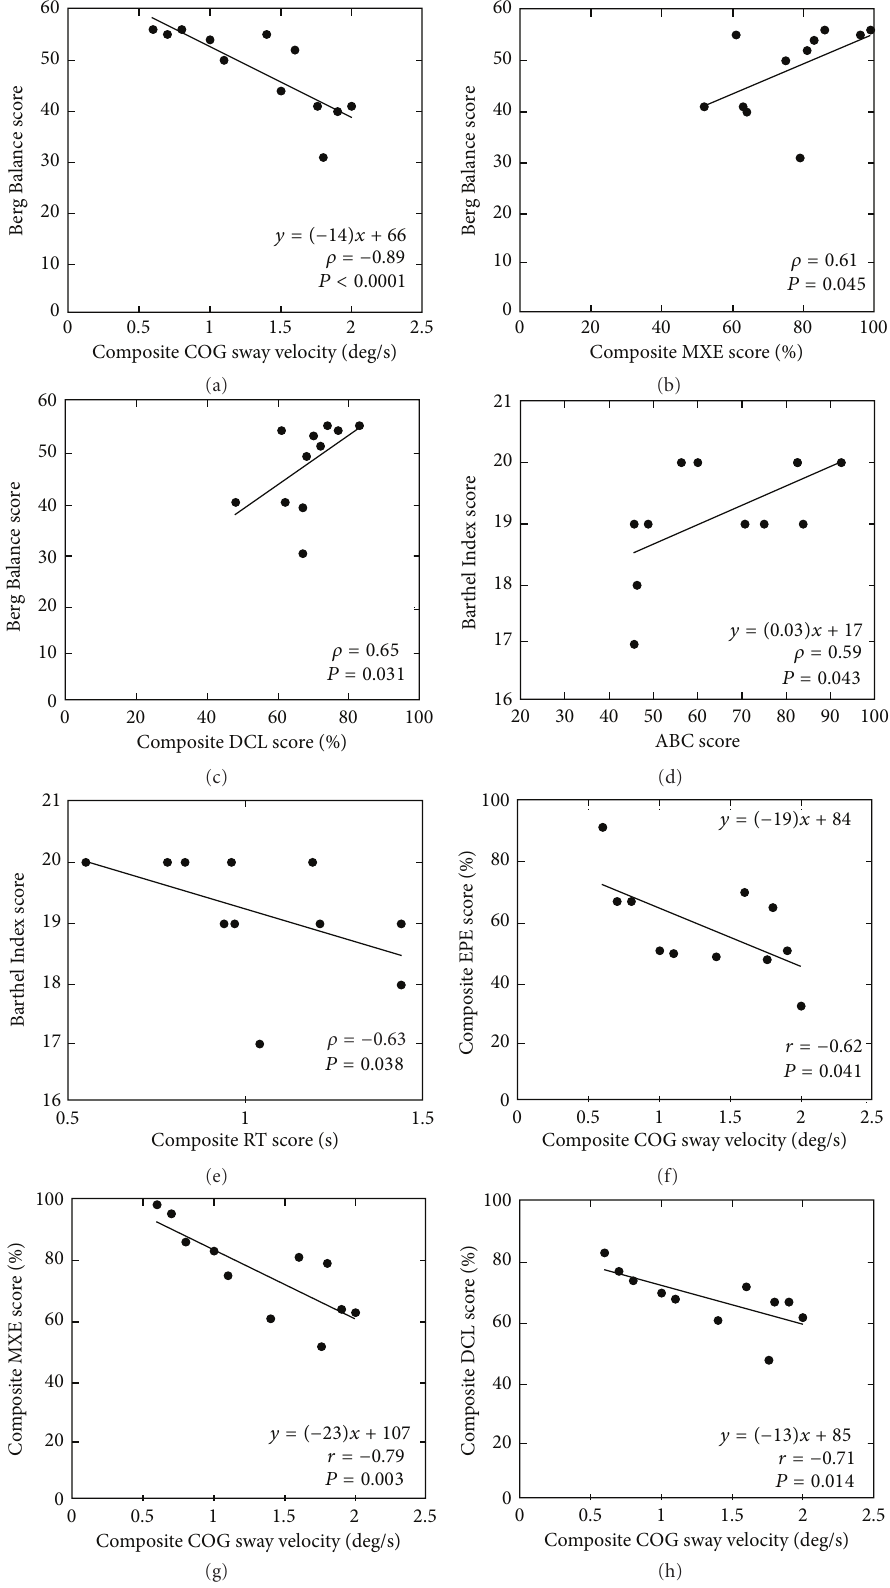
Figure 3: The results of correlation and regression analysis between clinical and instrumented outcome measures for the MS group. Abbreviations as defined in Figures 1 and 2 captions. All correlations and regression analyses shown are statistically significant ( 𝑃 < 0.05